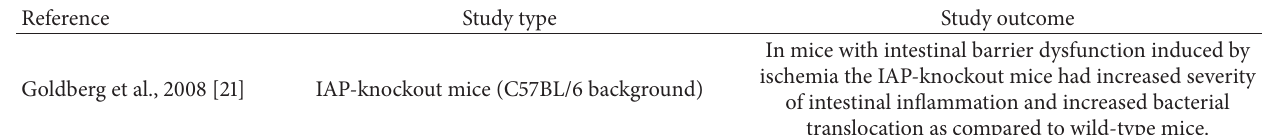
Table 1: Characteristics of animal studies examining potential role of IAP in experimental